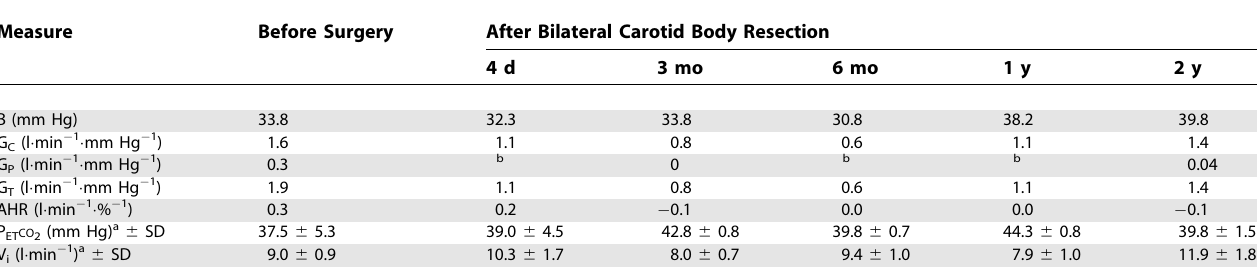
Table 2. Resting Variables and Parameters Obtained from the CO 2 and Hypoxic Challenges of Patient 2 over Time Measure Before Surgery After Bilateral Carotid Body Resection